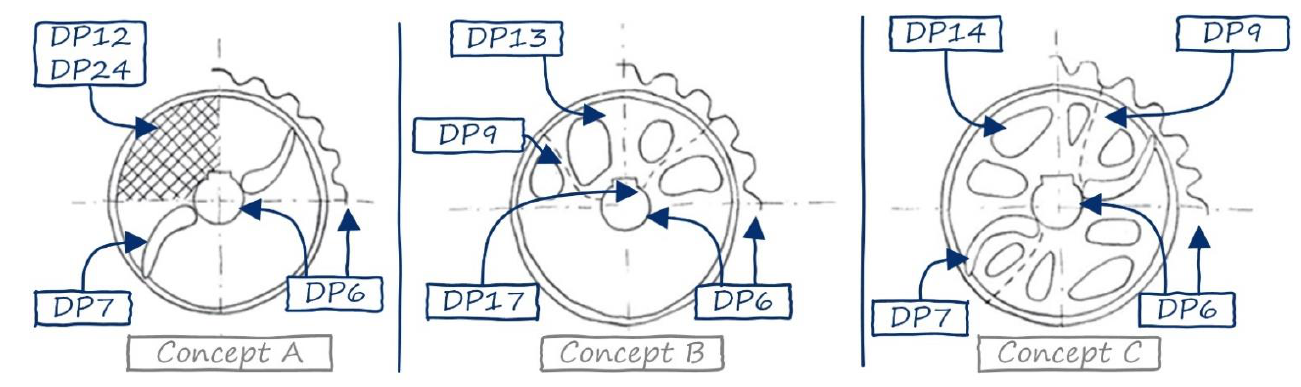
Figure 7. Created concepts of AM gear.